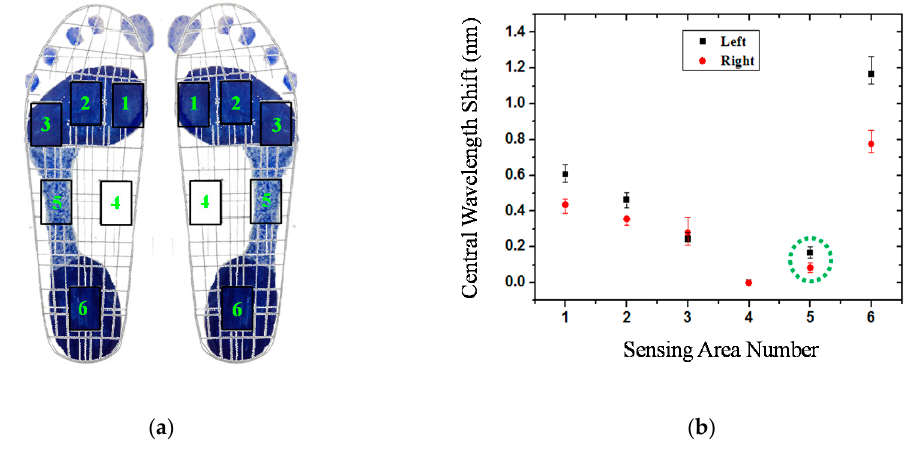
Figure 8. The plantar pressure distribution of the cavus feet of participant No. 6: ( a ) Footprint; ( b ) central wavelength shift as a function of sensing area number.